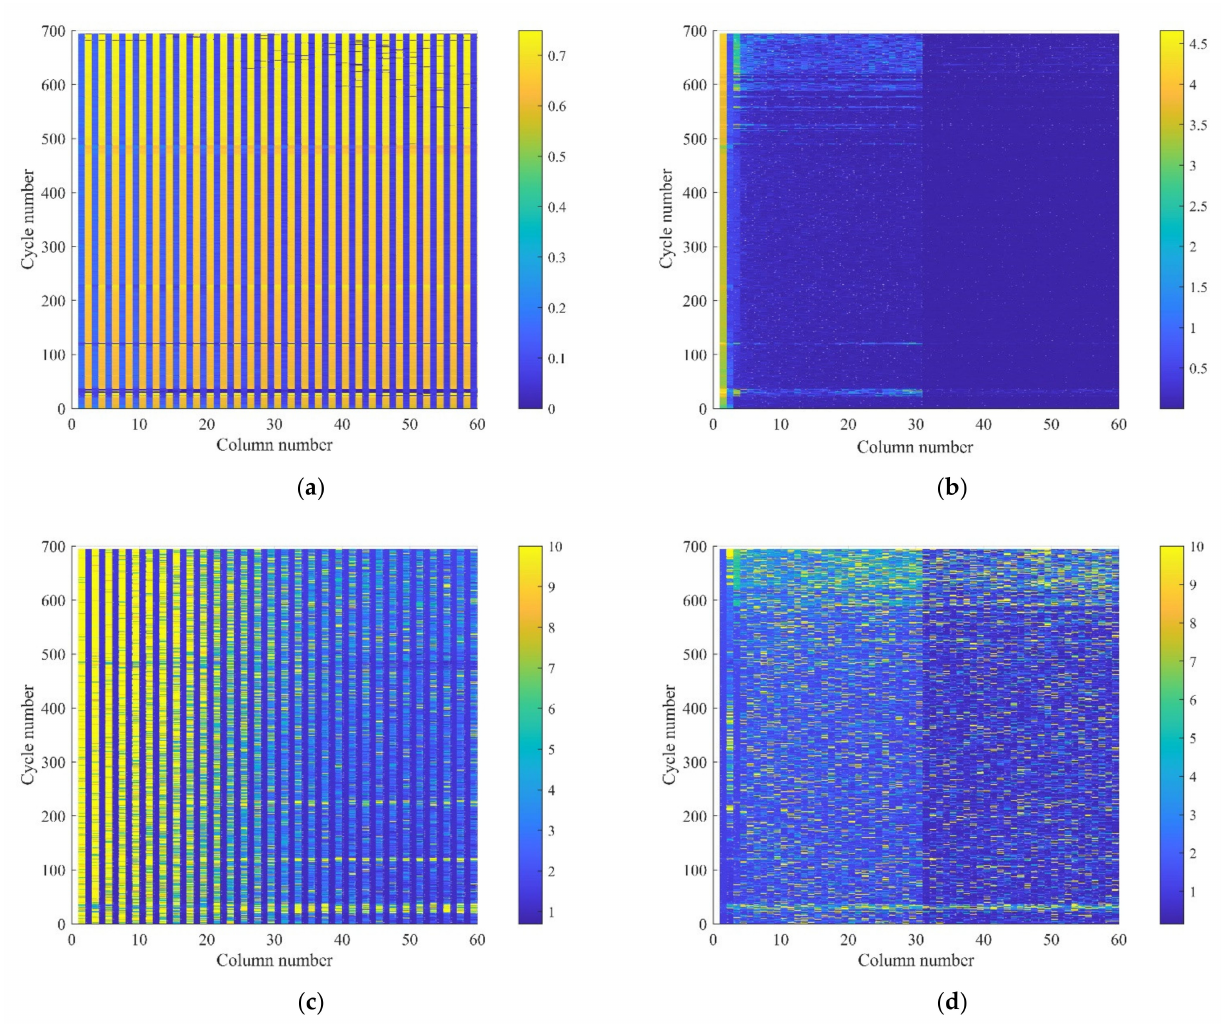
Figure 14. The ( a ) standard deviations of 694 cycles and ( b ) PC matrices; the ACV of ( c ) original matrices and ( d ) PC matrices.